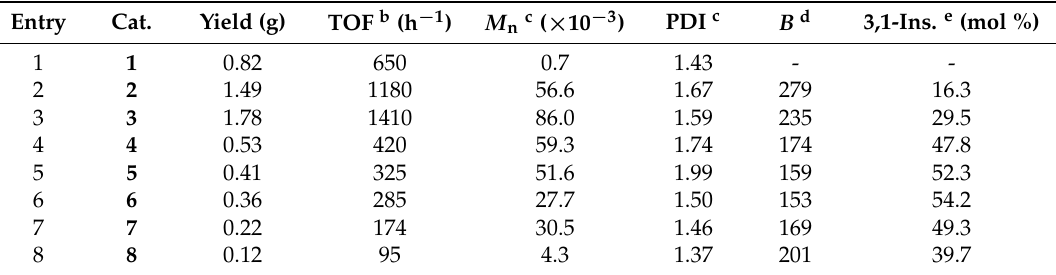
Table 1. Polymerization of propylene a